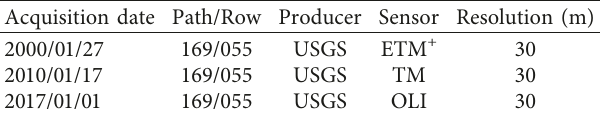
Figure 1: Location of the study area. Table 1: Details of satellite data